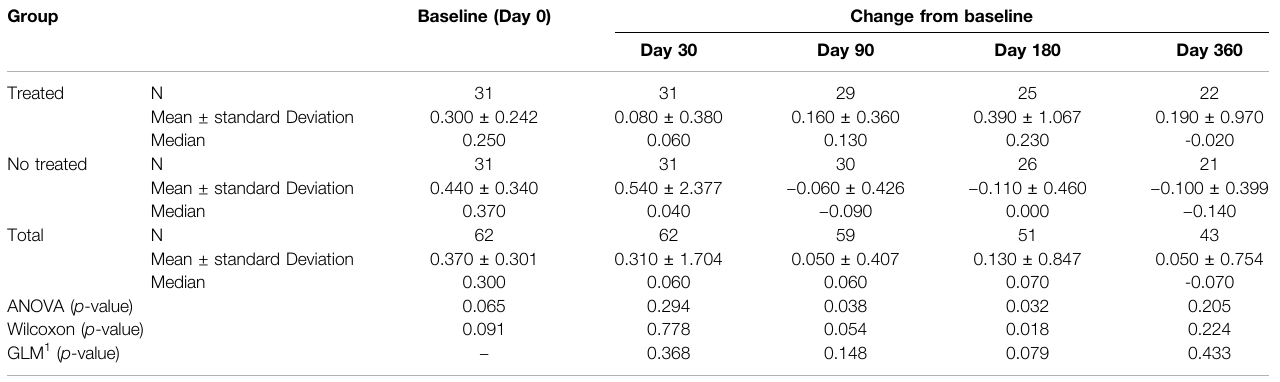
TABLE 3D | (part 4 of 4). GAIT parameters full cohort. Peak Knee Flex-Extension Moment. General Linear Model with Peak Knee Flex Extension Moment change from baseline as dependent variable, treatment as factor, and Peak Knee Flex Extension Moment baseline value as covariate.